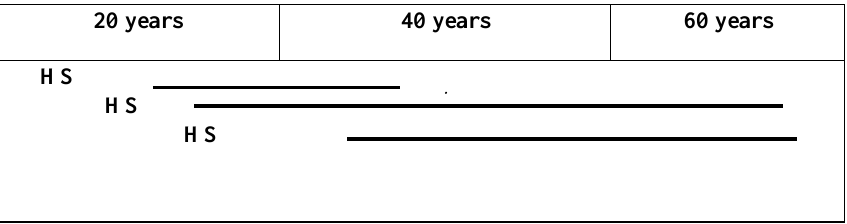
Table 4: Dunnett’s T3 between Ms fraction among different